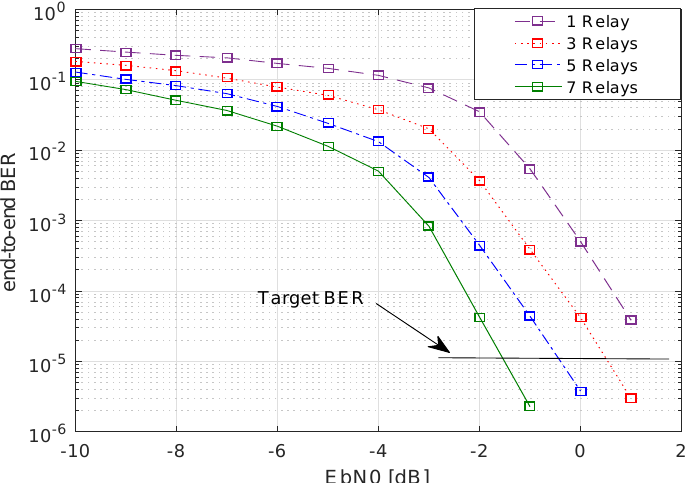
Figure 5. EPA-I: BER of system with multiple relays with equal transmit power (decreased by a factor of 2), code rate 1/2, codeword length n = 648, Nakagami- m fading m 1 = m 2 = 3, and